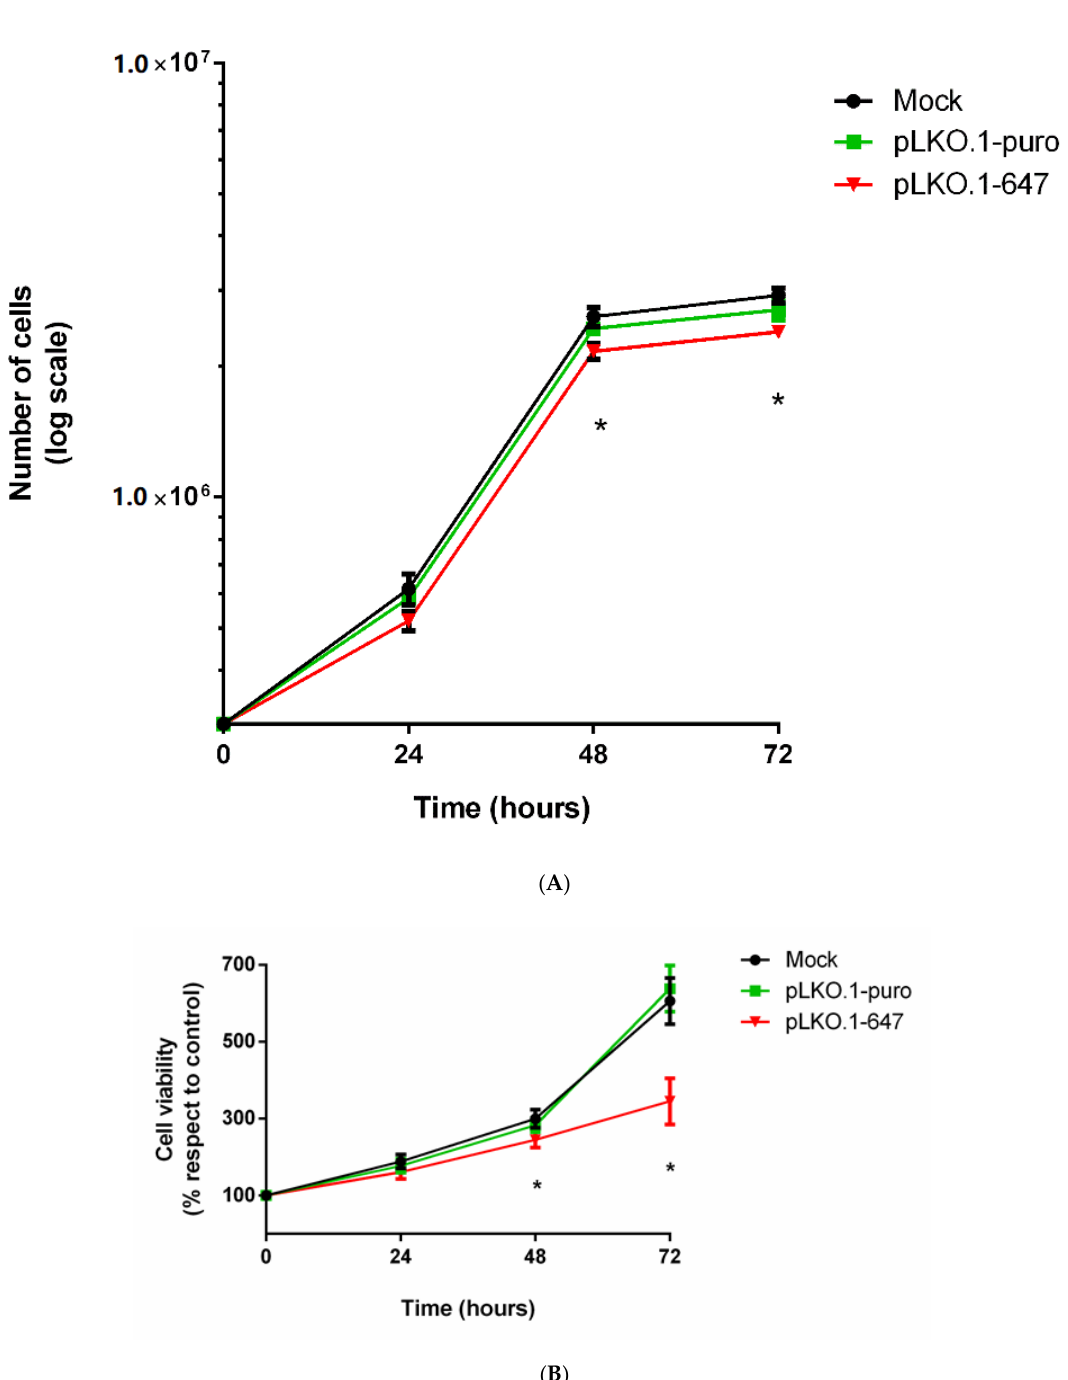
Figure 2. In vitro effect of PON2 silencing on cell proliferation and cell viability. Cell proliferation was analyzed by trypan blue exclusion assay in control samples (mock and pLKO.1-puro) and PON2 downregulating cells (pLKO.1-647) at 0, 24, 48, and 72 h (panel A ). Cell viability was evaluated through MTT assay (panel B ). Values are expressed as mean ± standard deviation (* p < 0.05).